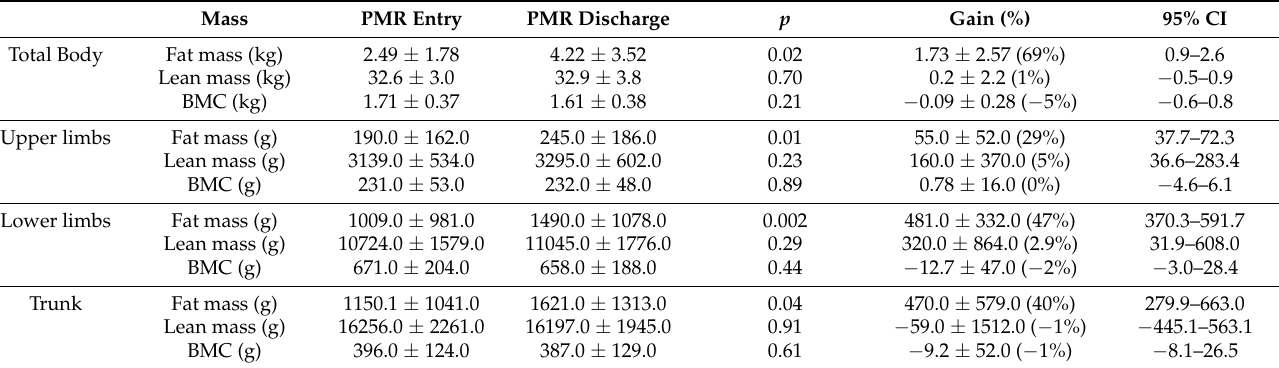
Table 3. Fat mass, lean mass, and mineral content evolution (Body Dual X-ray